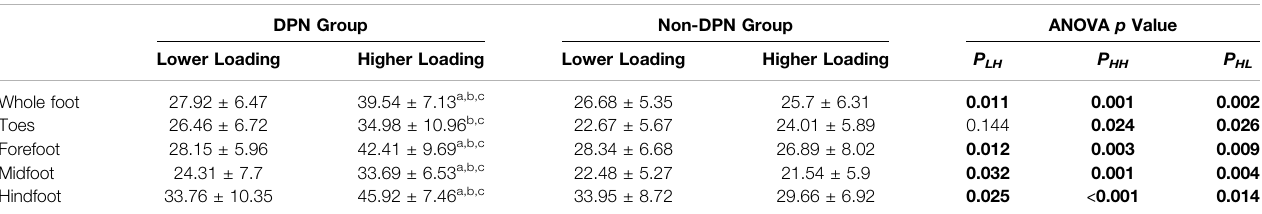
TABLE 3 | The effect of peripheral neuropathy and plantar loading patterns on plantar tissue hardness (Mean ±